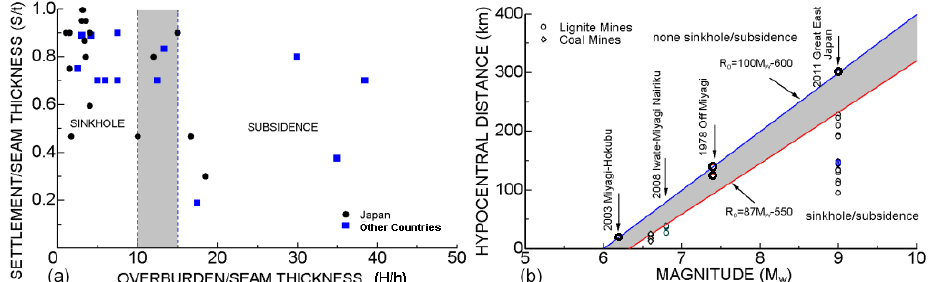
Figure 3. (a) Normalized seam height versus normalized settlement; (b) moment magnitude of earthquakes versus the hypocentral distance of sinkhole/subsidence localities.